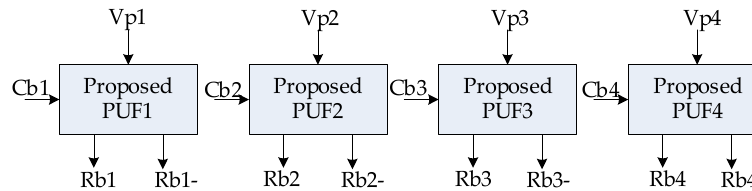
Figure 6. Proposed 4-bits PUF architecture.